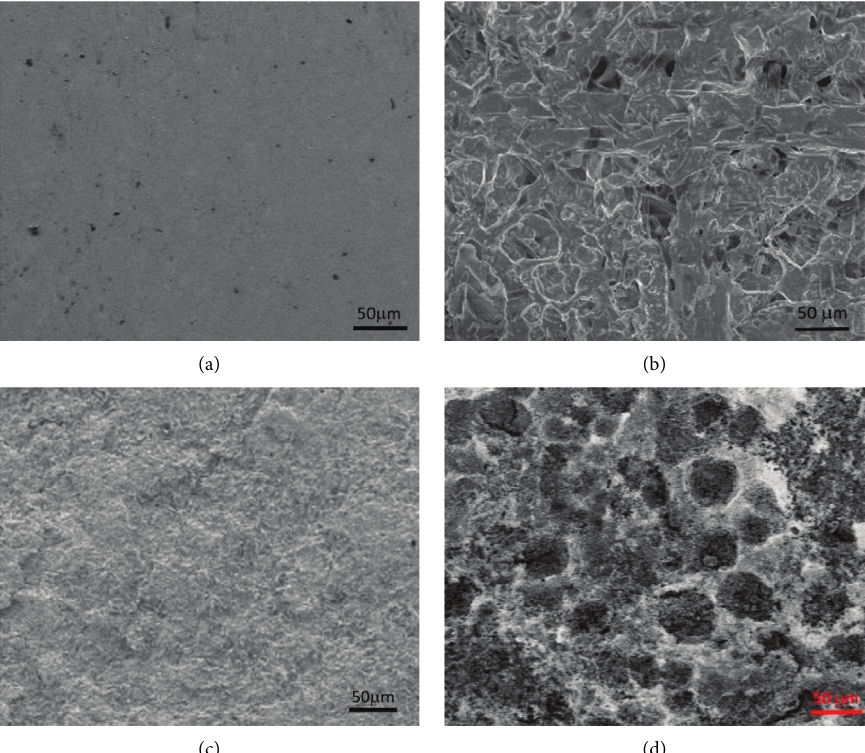
Figure 3: The SEM images of the SnO 600 ° C